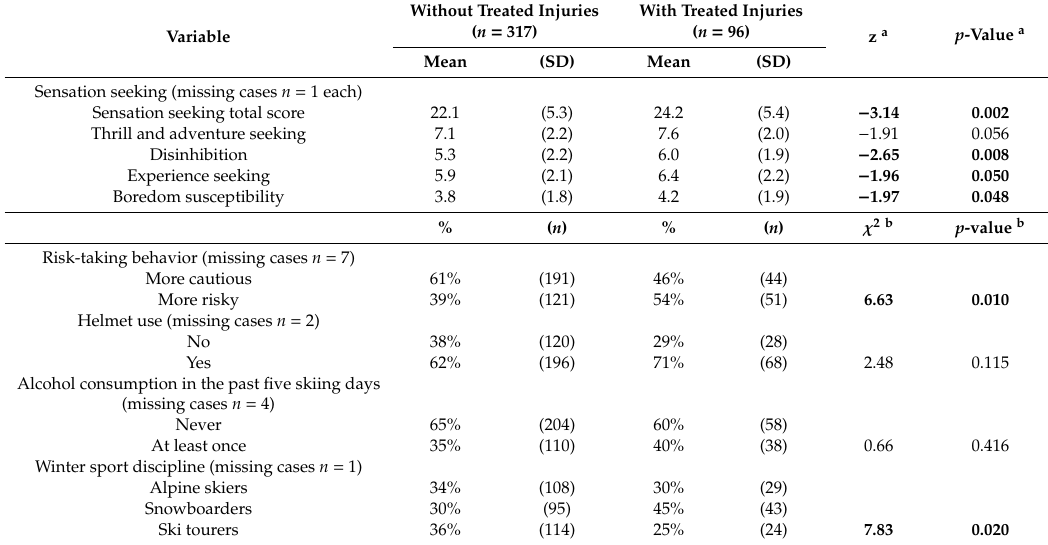
Table 3. Injury-related behavioral variables separately for participants with and without injuries requiring medical care on ski slopes. Without Treated Variable